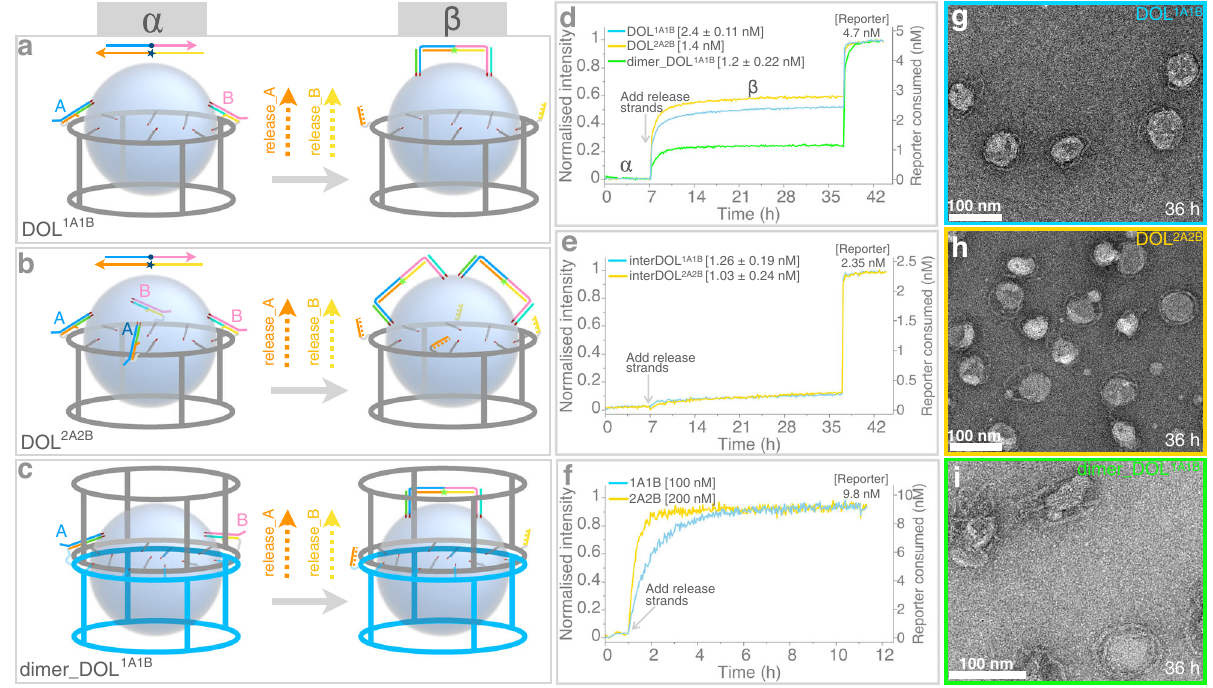
Fig. 2 | Receptor reactions on three DOL variants. a – c Different platforms stu- died by varying the number of receptors or rings. Right side of arrow shows the ternary complex depending on the initial number of receptors tethered on a DOL platform(leftsideof arrow).The DNAcircuit logic(Fig.1b)issamein a – c . Labels α and β represent the states corresponding to fl uorescence intensity curves in d